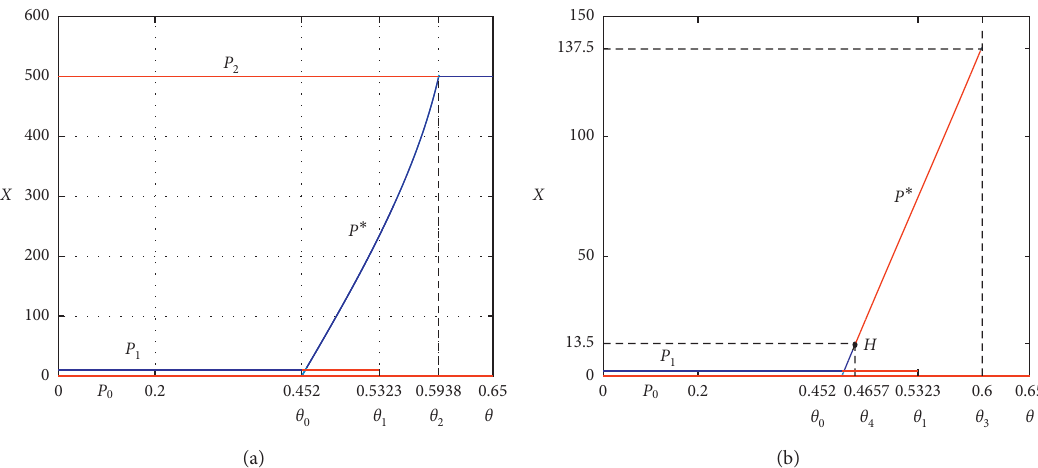
Figure 4: The bifurcation diagrams of x with respect to θ for different ω the blue curve, and the unstable one corresponds to the red curve. The equilibria are P P ∗ ( x ∗ ,y ∗ , z ∗ ,u ∗ ) of system (3) (in order to distinguish P